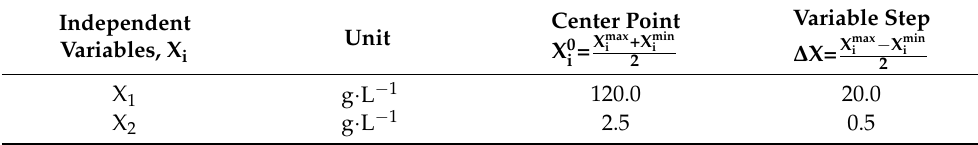
Table 5. Actual value of independent variable at the center point and the change in variable step. Independent